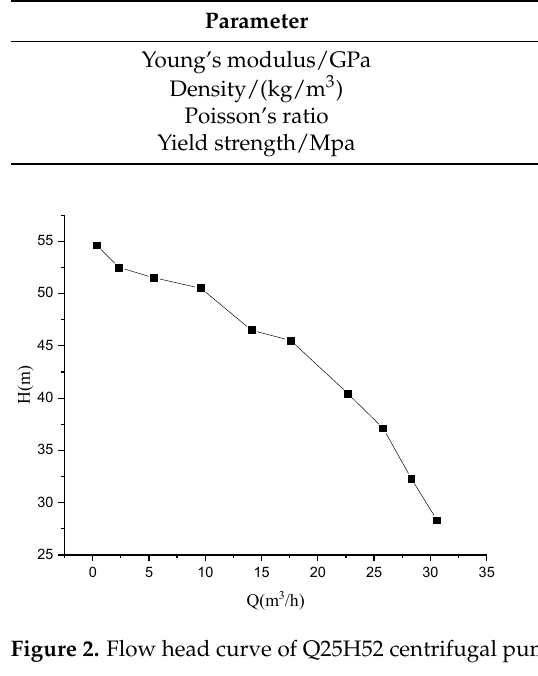
Figure 4. Flomaster simulation experiment platform of centrifugal pump. By setting the parameters of each component, the variation data of motor speed and flow with time in the first two seconds of the centrifugal pump start-up process can be obtained. As shown in Figure 5, the speed and flow of the centrifugal pump do not di- rectly reach the rated speed and flow at the beginning but go through a process of change. The speed and flow first increase rapidly until they exceed the rated speed and flow, and then begin to decrease. It presents a wave type change and remains relatively stable near the rated speed and rated flow. 0.0